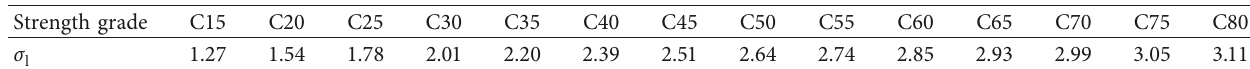
Table 7: Standard value of axial concrete tensile strength (MPa)